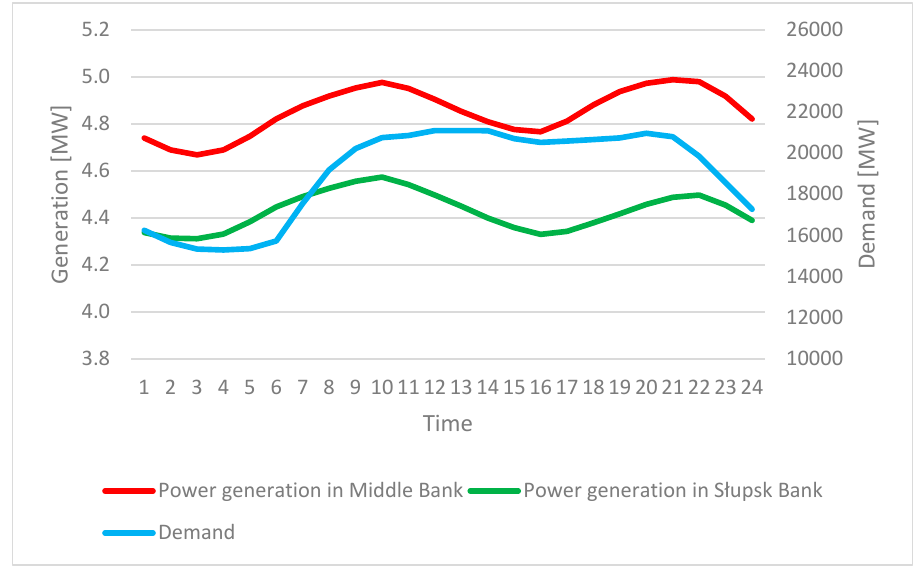
Figure 4. Correlation between generation and average hourly demand.